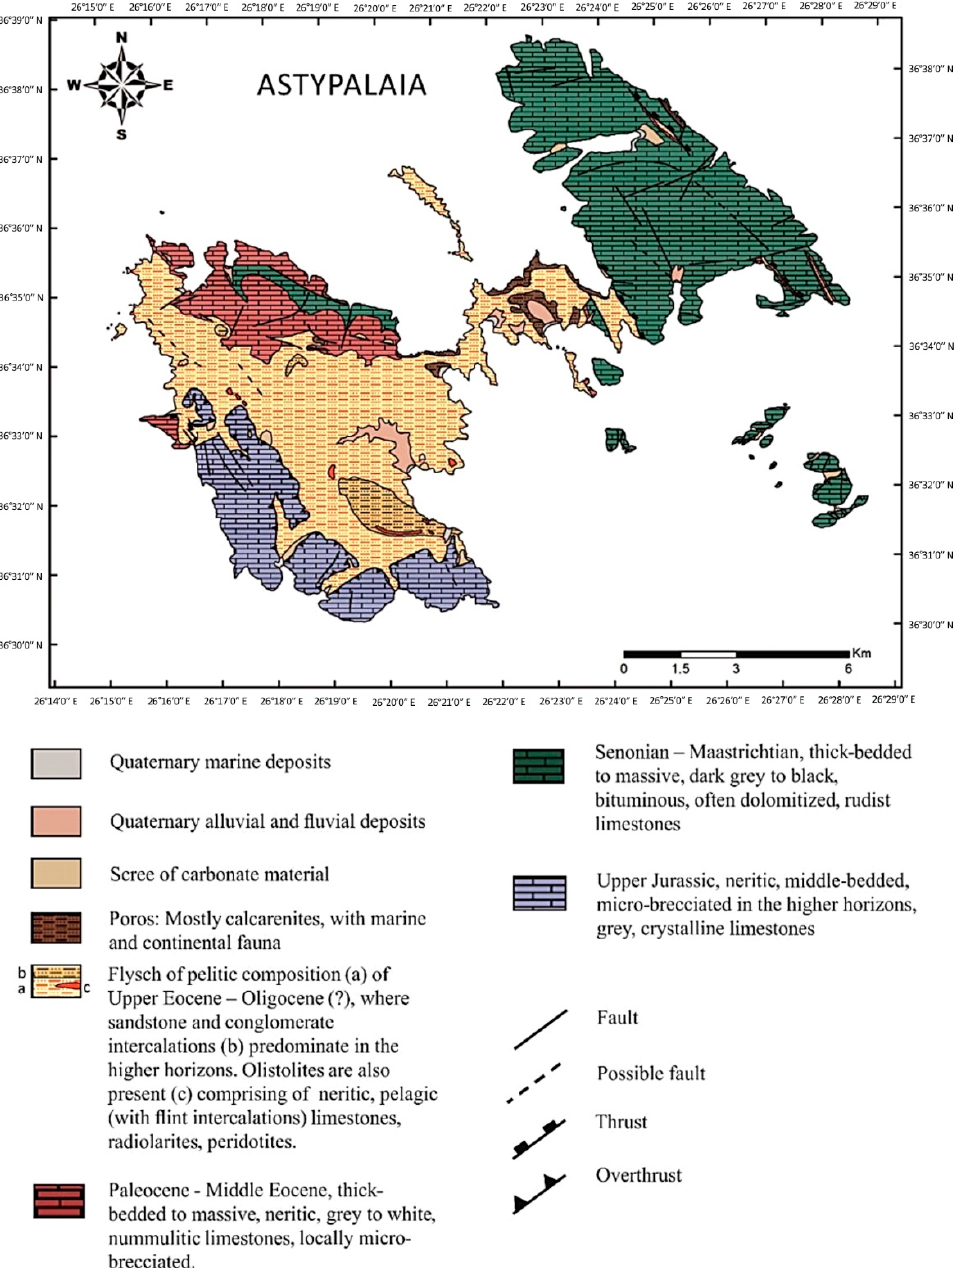
Figure 5. The geological map of Astypalaia (digitized and modified from [34]).